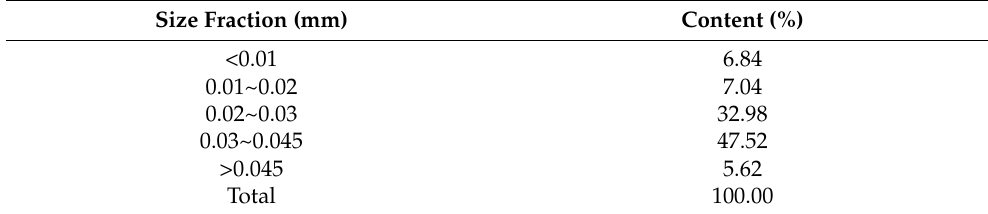
Table 1. Size distribution of magnetite powder.